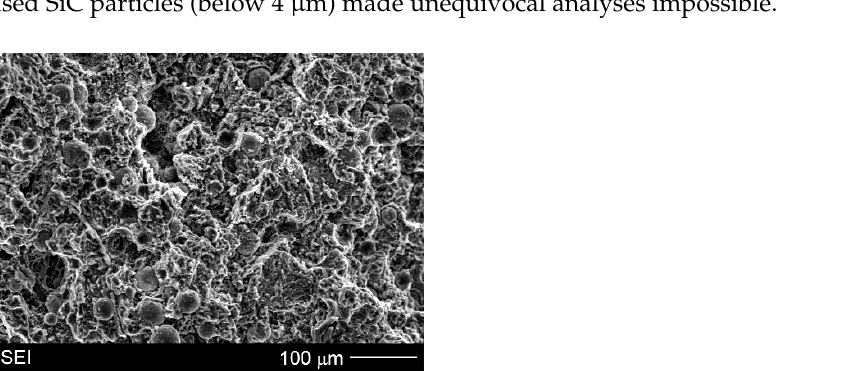
Figure 10. SEM micrograph of fracture surface of AZ91/(SiC + Ti) p hybrid composite (after uniaxial tensile test).